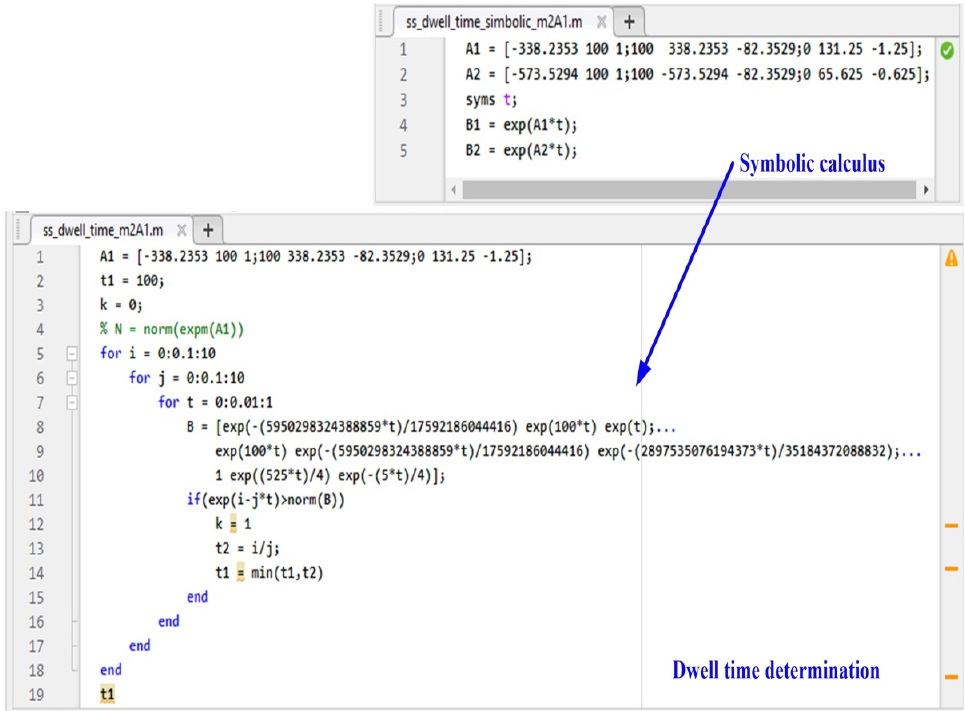
Figure 13. Matlab program for dwell time determination—variable structure 1.